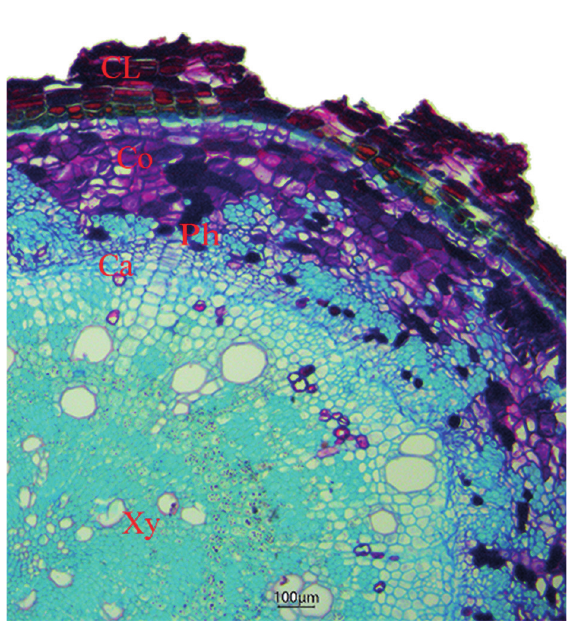
Figure 3 - Transverse section of root. CL: cork layer; Co: cortex; Ph: phloem; Ca: cambium; Xy: xylem. Bars: 100